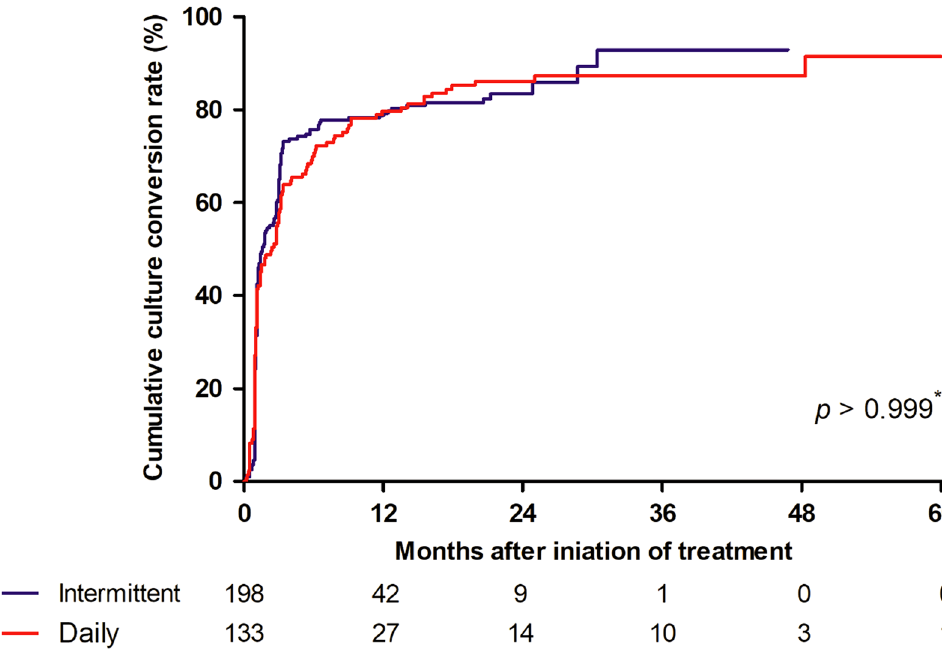
Figure 3. Cumulative culture conversion rate according to treatment modalities in the BACES mild group (n = 331).